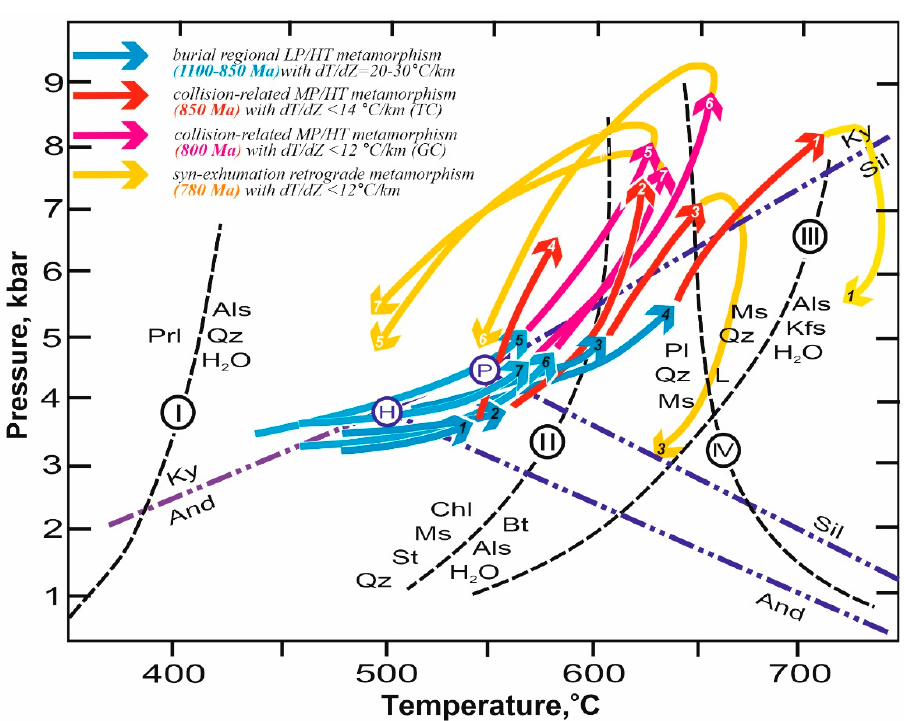
Figure 9. P–T diagram showing the generalized P–T path calculations for metapelites in the Teya and Garevka complexes. Studied areas: curve 1—Chapa, 2—Polkan; 3—Teya, 4—Mayakon, 5—Yenisey River, 6—Tis River, 7—Garevka River.